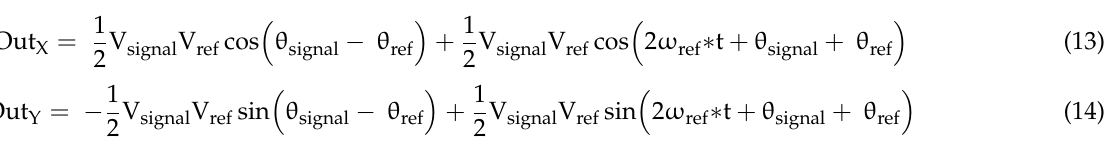
The signals in Equations (13) and (14) are passed through LPF to eliminate the high- frequency components and as a result we can obtain only in-phase and quadrature-phase components as X and Y in Equations (15) and (16).